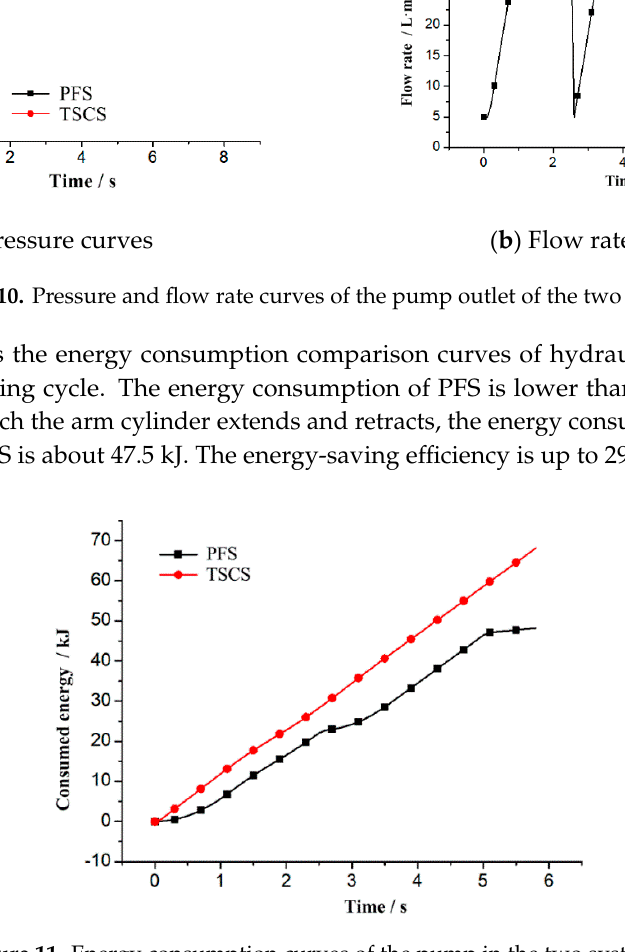
Figure 12. A 1.5 t excavator test rig.